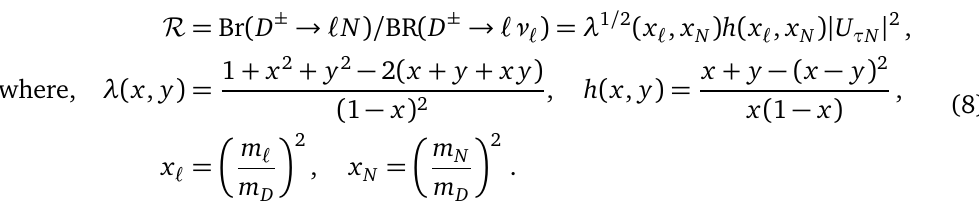
to illustrate N